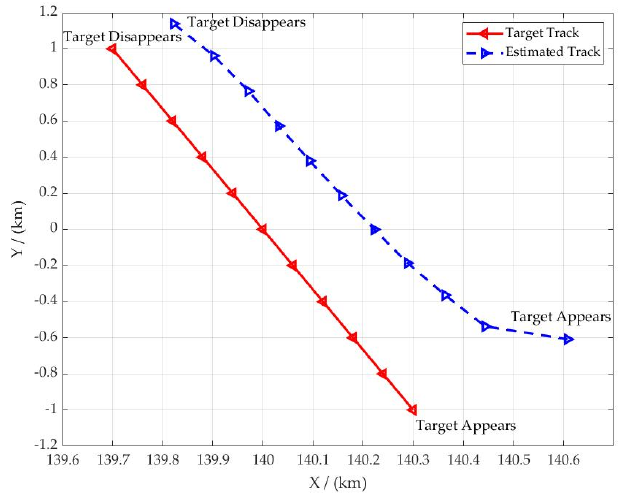
Figure 10. Target detection results by the modified ICMB filter.